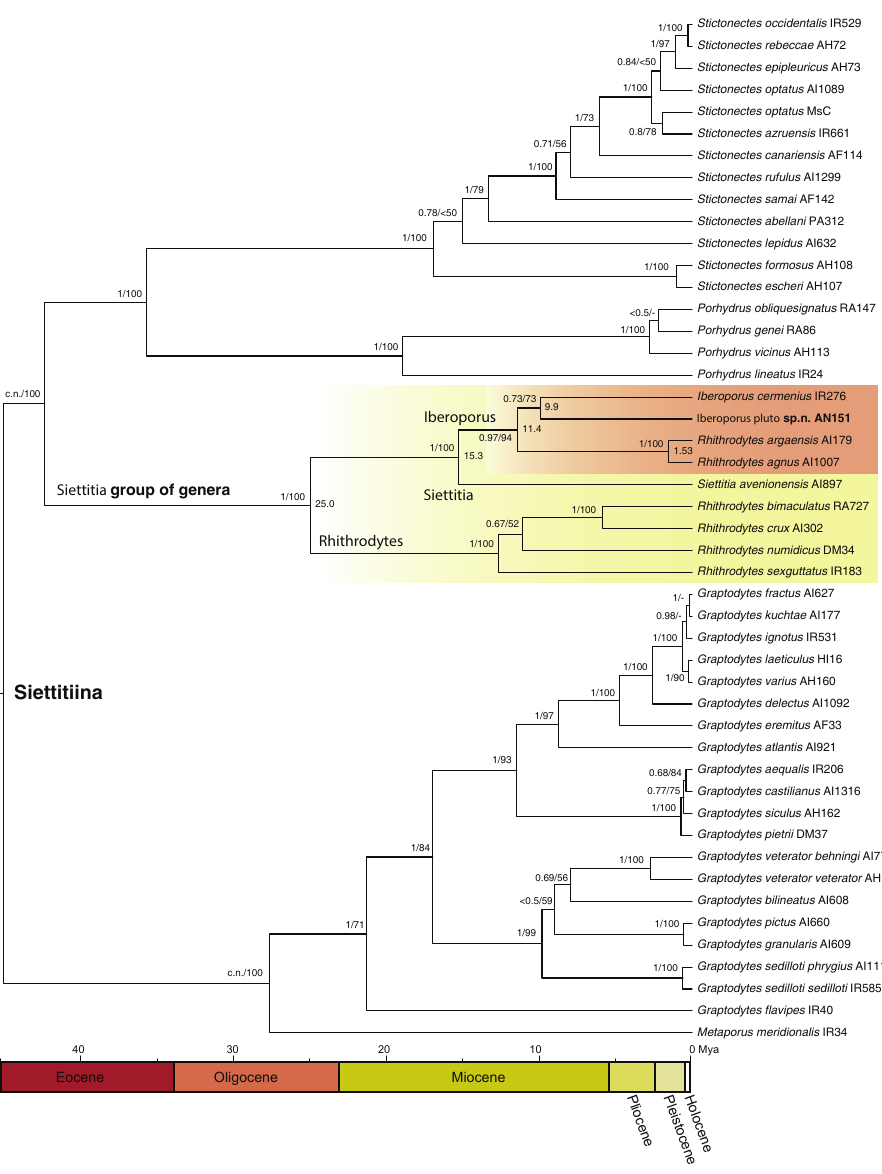
Figure 1. Phylogeny of the Siettitia group of genera, obtained with Bayesian methods. Numbers in nodes, Bayesian posterior probabilities/maximum likelihood bootstrap support (obtained in RAxML); c.n., constrained node in the Bayesian analysis. See Table 1 for details on the specimens.